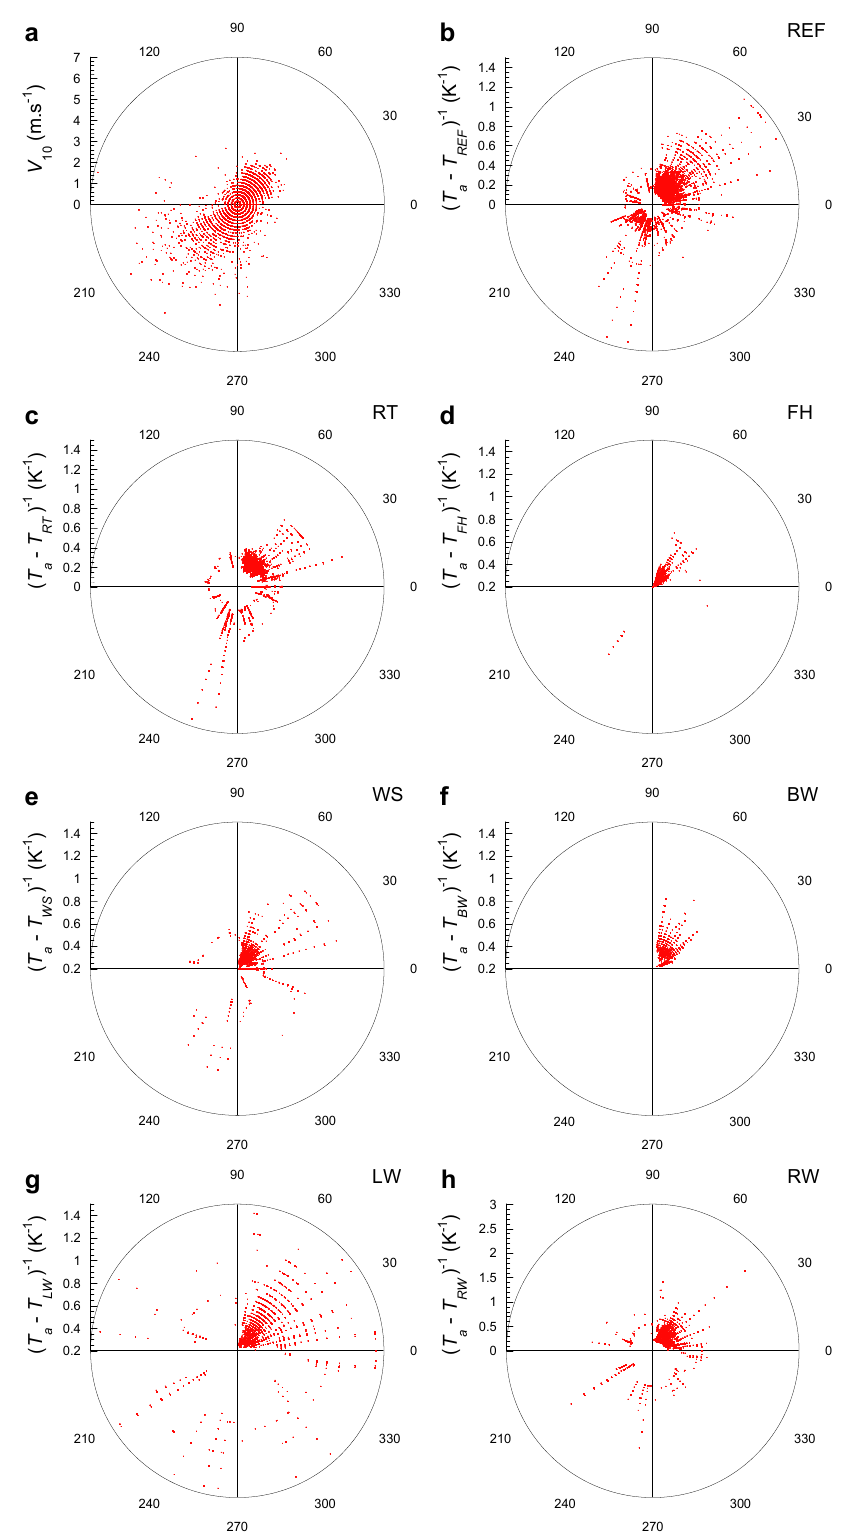
Figure 14. ( a ) Windspeed versus wind direction during dew formation ( T j < T d ). ( b – h ) Instantaneous values of j - inverse surface temperature difference with air coefficient, with respect to wind direction Dir( V ) during condensation ( T j < T d ). ( b ) Reference foil, ( c ) rooftop, ( d ) front hood, ( e ) windshield, ( f ) back window, ( g ) left window, ( h ) right window. VW and AD cars are both